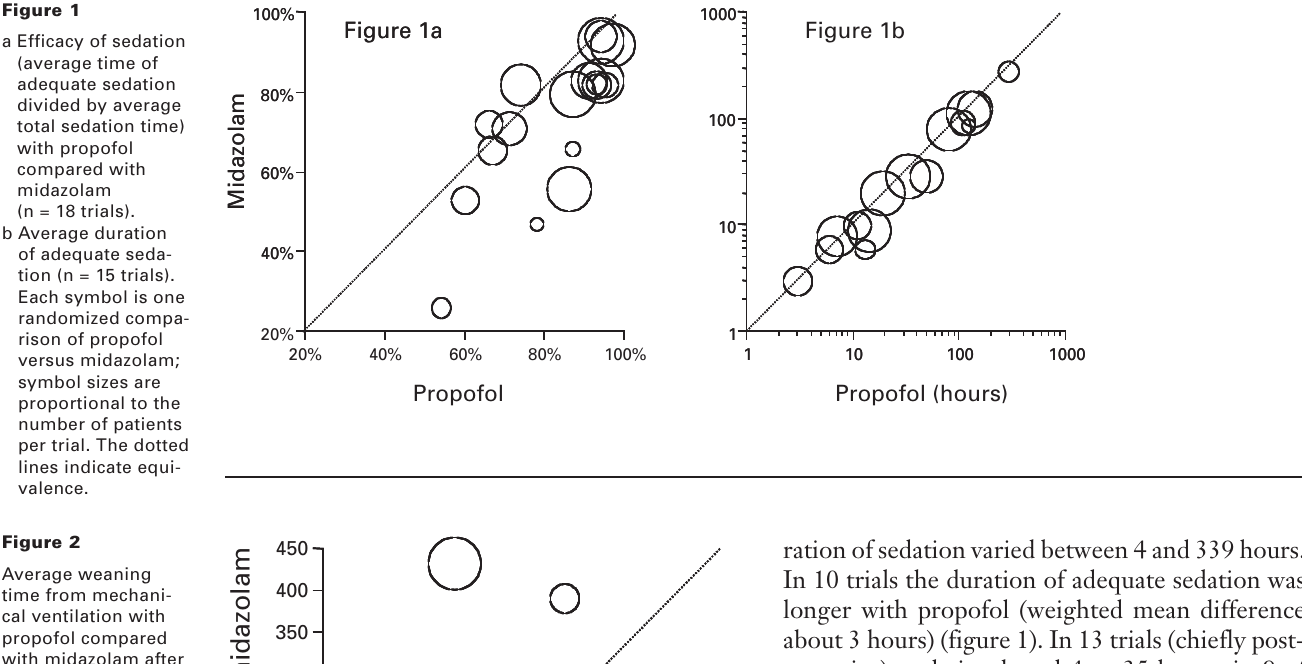
Average weaning time from mechani- cal ventilation with propofol compared with midazolam after short-term sedation (<36 hours). Each symbol represents one randomized com- parison. Symbol size are proportional to the number of pa- tients per trial. The dotted line indicates